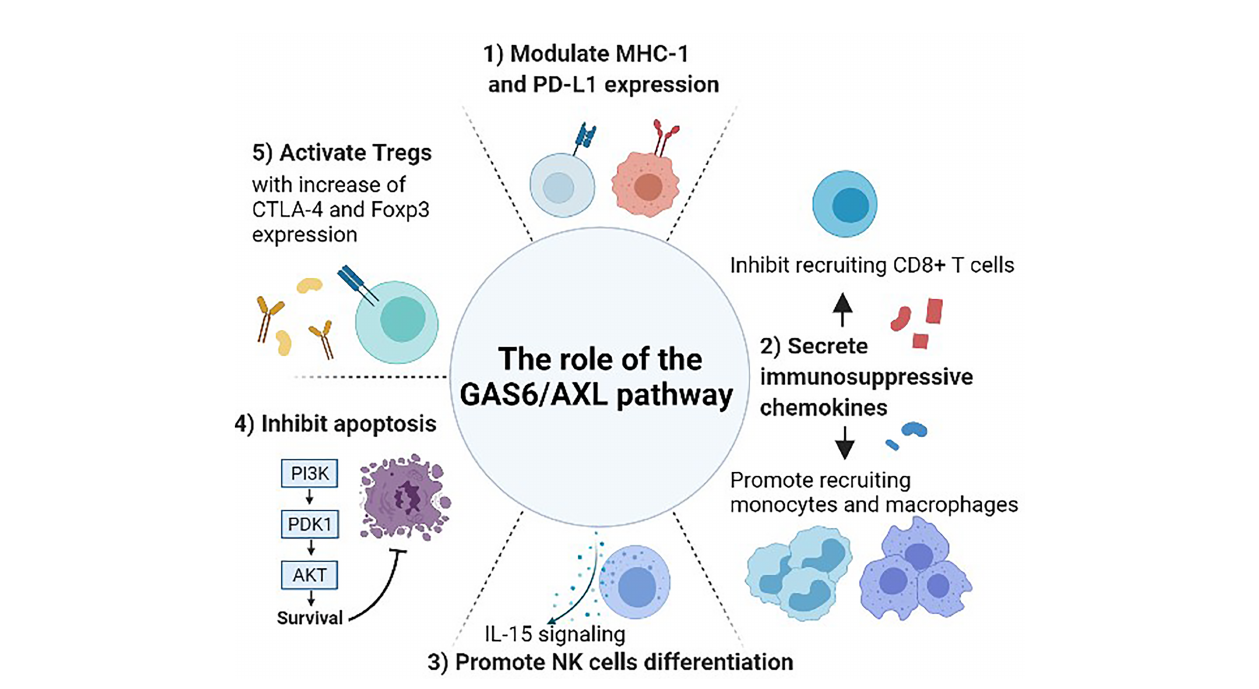
FIGURE 2 | The role of the GAS6/AXL pathway between cancer and immune system. Gas6 promotes Axl expression in cancer cells, and the Gas6/Axl signaling affects tumor cell migration, invasion, survival, and proliferation. After forming the homodimerized complex, the Gas6/Axl signaling affects several downstream effectors including pAkt and pStat3 that lead to several changes in the tumor microenvironment and immune system. 1) Modulate the expression of MHC-1 and PD- L1. 2) Regulate the secretion of chemokines that are involved in recruiting several immune cells including monocytes, macrophages, and CD8+ T-cells. 3) Promote NK cell development through IL-15 signaling. As interruption of the GAS6/AXL pathway resulted in a reduction of FLT3 phosphorylation, this pathway may induce differentiation of NK cells by positively regulating FLT3 activation. 4) Inhibit apoptosis and activate phagocytosis involving several other pathways including activating the Akt and PI3K pathways. 5) Increase the immune-suppressive effect of Tregs. GAS6-induced CTLA-4 and Foxp3 expression are abrogated by blocking